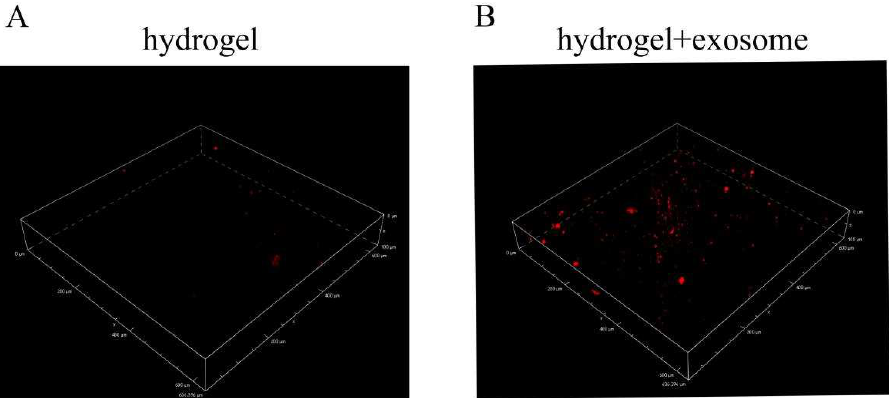
Figure 4. LSCM images of ( A ) hydrogel (control) and ( B ) hydrogel with red fluorescence DiD-labeled exosomes (hydrogel + exosome).